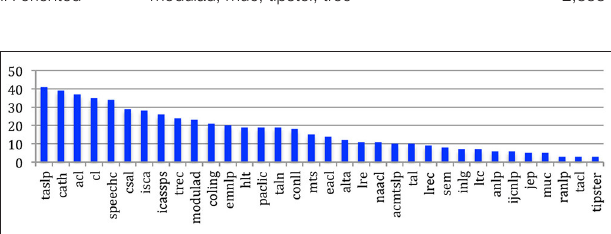
FIGURE 2 | Time span for each source (years).